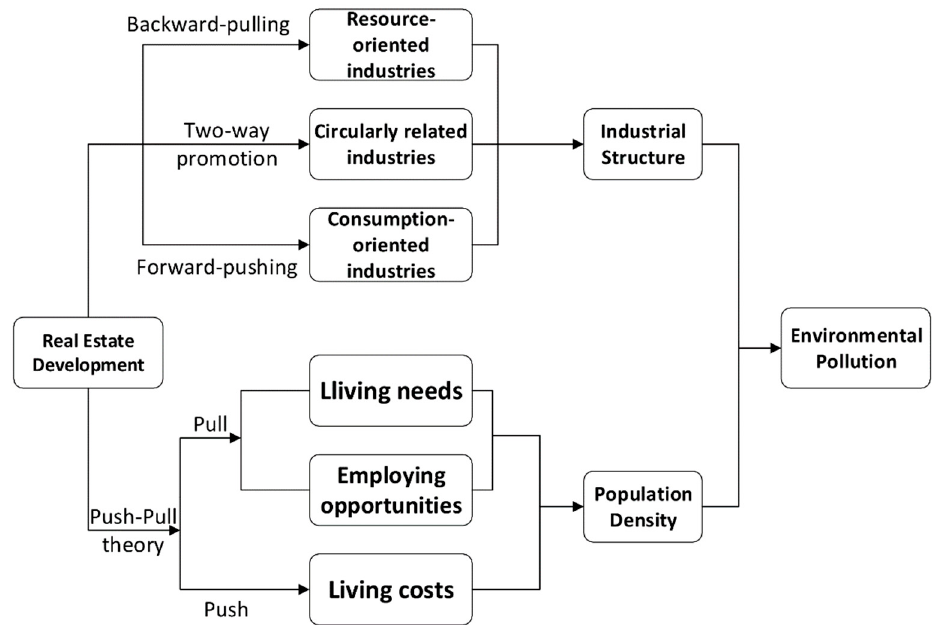
Figure 3. The mechanism of the impact of real estate development on environmental pollution.